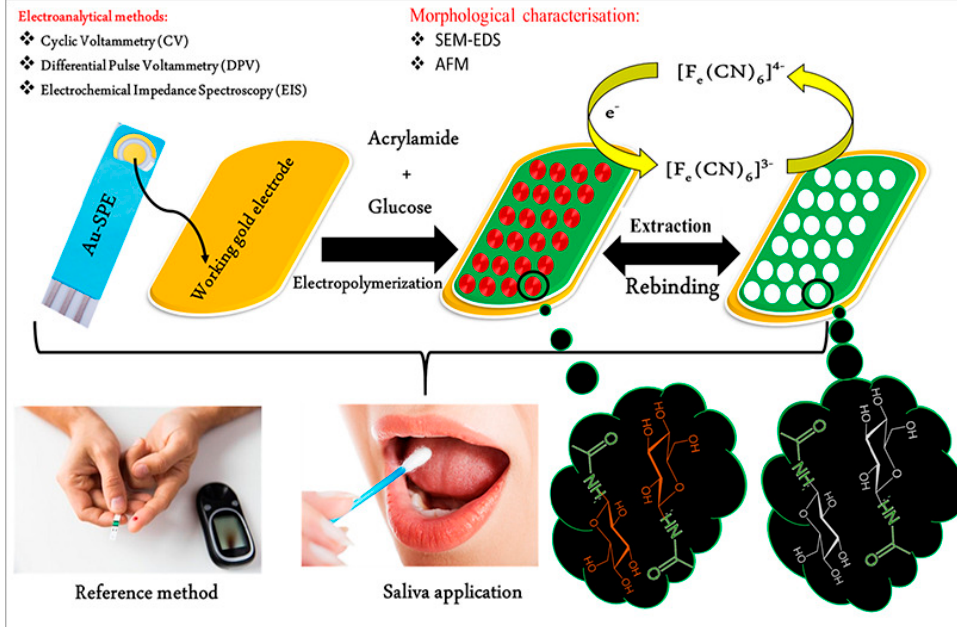
Figure 4. Fabrication of a MIP-based Au SPE by electropolymerizing AAM/NNMBA in the presence of glucose and its application in saliva samples. Figure reproduced with permission from ref. [86].